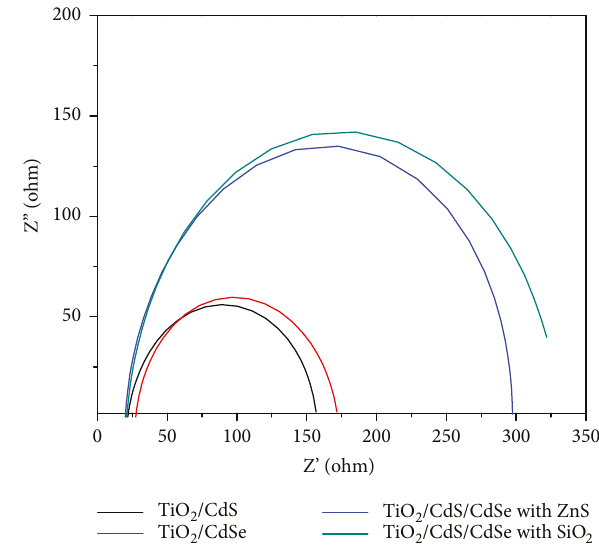
Figure 5: Nyquist of the